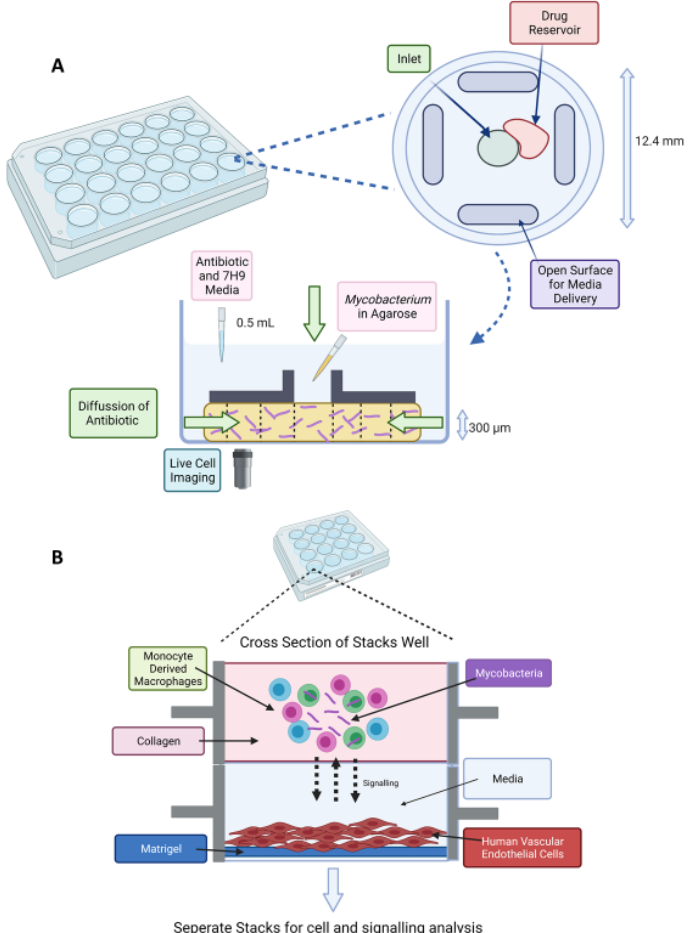
Figure 4. ( A ) Stacks microfluidic platform for analysing soluble signalling. The top layer contains the granuloma model in collagen and the bottom layer contains human vasculature endothelial cells on a Matrigel layer. Soluble factor signalling can be studied from the granuloma microenvironment [164] . ( B ) Schematic of DAC system. A 24-well plate fabricated from poly(methyl methacrylate) (PMMA) with a top view of an individual well (diameter of 12.4 mm and height of 12 mm). The disc-shaped channel (300 μ m depth) is filled with agarose and mycobacteria. An inverted micro- scope is placed underneath for time-lapse imaging [159] . Created on BioRender.com, accessed on 26 October 2021.